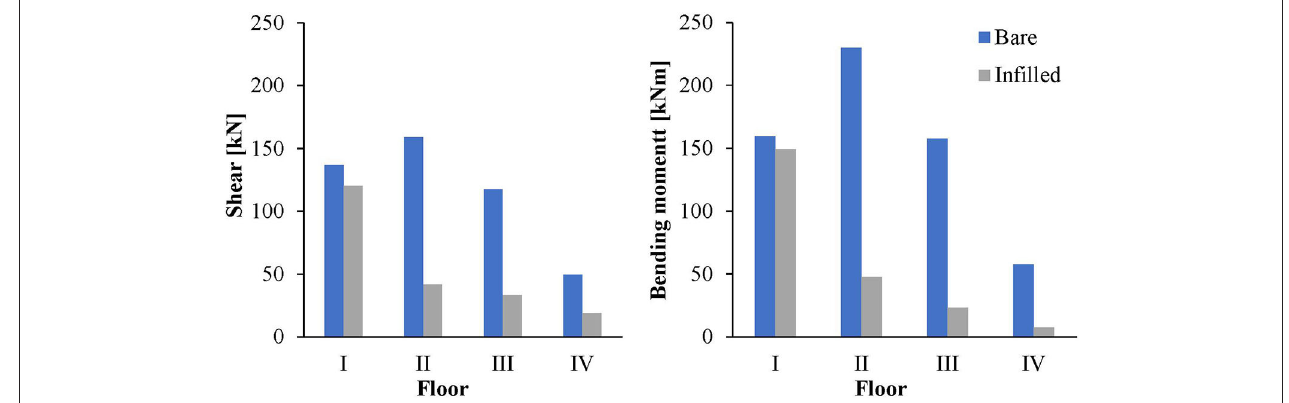
FIGURE 8 | Shear and bending moment stresses for a typical beam.